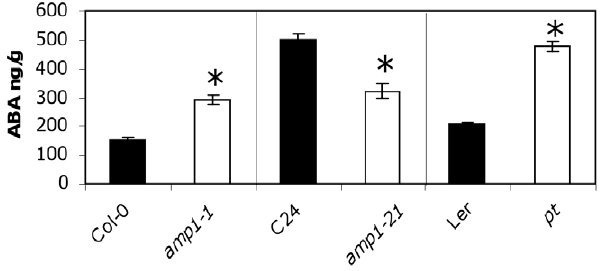
Figure 5. ABA content of dry wild-type and amp1 mutant seeds. ABA was extracted from seeds one week after harvest. Means of three biological replicates with their SE are shown. *Statistically significant difference in a Student’s t-test (P , 0.05; n =4).